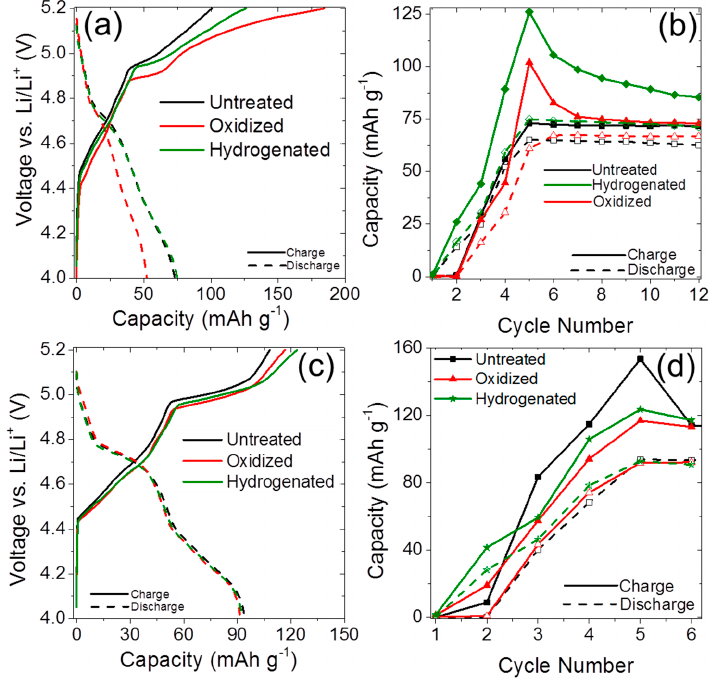
Figure 1. ( a ) Capacity vs. Voltage (vs. Li/Li + ) of first cycle full-potential C/10 charge and discharge (between 4.0 and 5.2 V)) for differently functionalized MesoCarbon MicroBeads (MCMB) cathodes. (b ) Corresponding charge/discharge cycle profiles (including 4 initial pre-conditioning cycles) for MCMB cathodes. Corresponding charge/discharge and capacity plots are shown in ( c ) and ( d ) for chemically modified Synthetic Flakes of Graphite (SFG) cathodes. Hydrogenated MCMB cathodes demonstrated noticeably different charge/discharge behaviors.